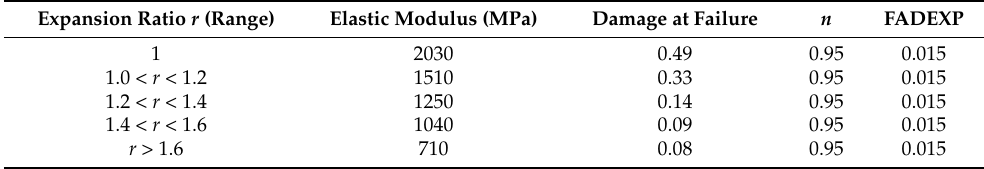
Table 3. Model parameters are the input for the GISSMO